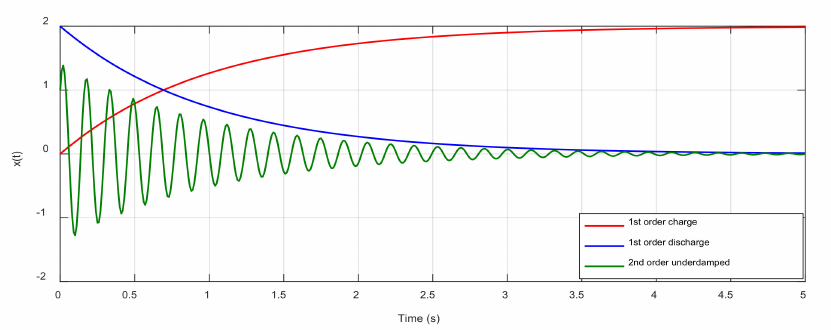
Figure 1. Transient response of the